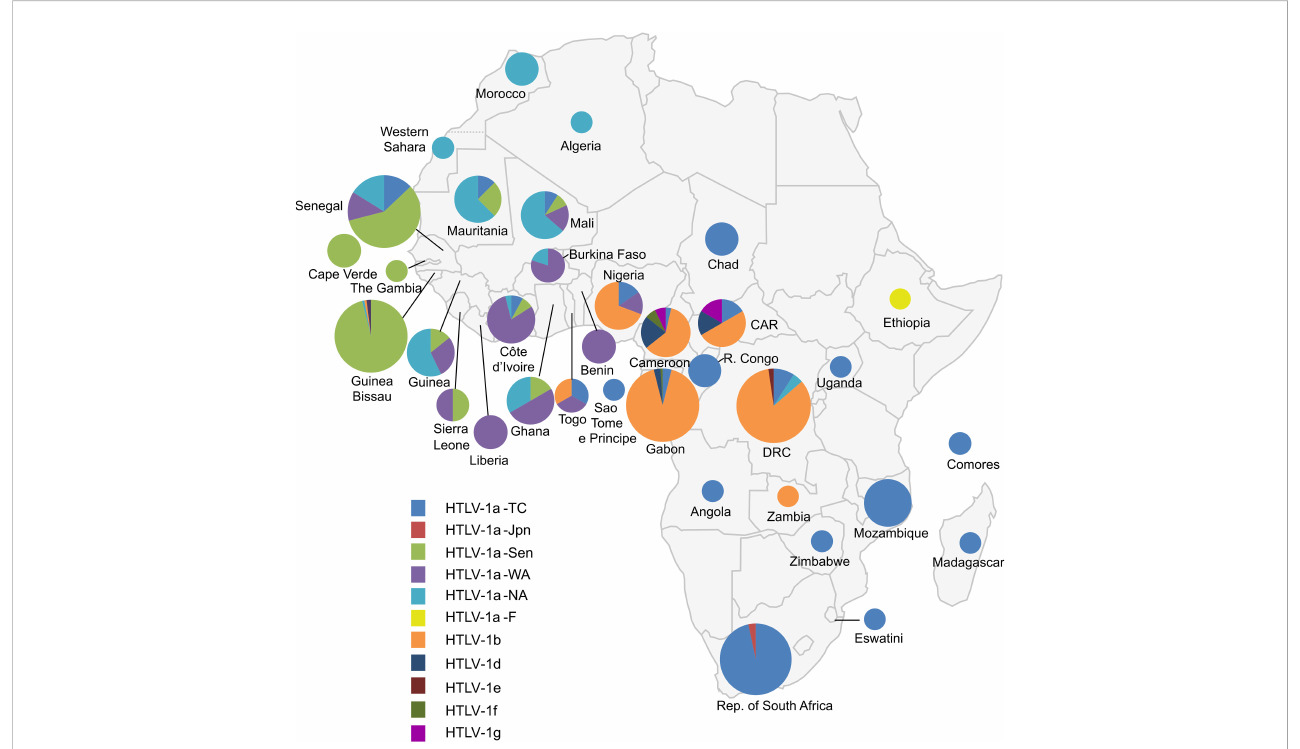
FIGURE 8 Map of Africa showing the general distribution of HTLV-1 genotypes across the continent [Source: Afonso et al., Retrovirology, 2019 – (218)]. The proportion of the different HTLV-1 genotypes and subgroups is presented for each African country. This fi gure incorporates the information from 24 papers of molecular epidemiology available on PubMed. It also incorporates results from one manuscript in preparation (Filippone C. et al.) concerning the situation in Madagascar. Countries without indications have no informative published data on HTLV-1 genotypes between 1994 – 2019. The size of the circles is proportional to the number of strains identi fi ed. The smallest size corresponds to 1 characterized strain, the intermediate sizes to a maximum of 5 or 30 strains and the largest to a minimum of 30 strains. HTLV-1a-North African (HTLV-1a-NA), HTLV-1a-Senegalese (HTLV-1a-Sen), HTLV-1a-West African